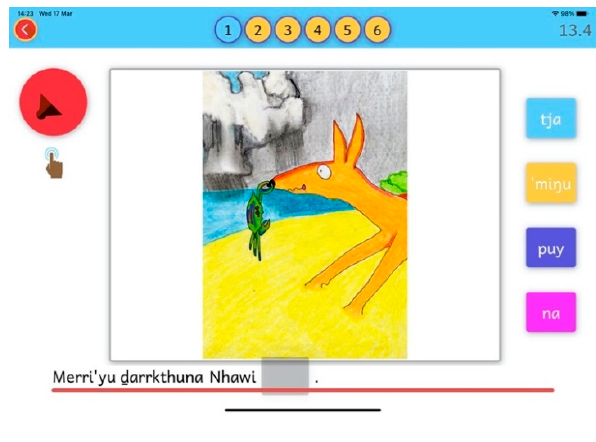
Figure 6. Item 1, 13.4.